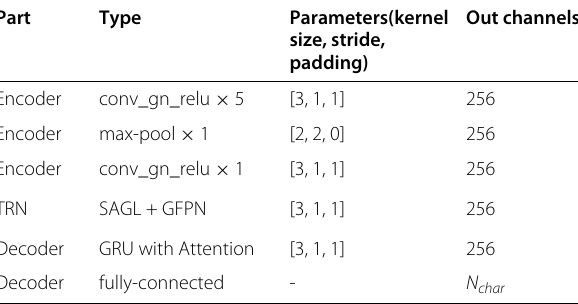
Table 1 The architecture of the recognition